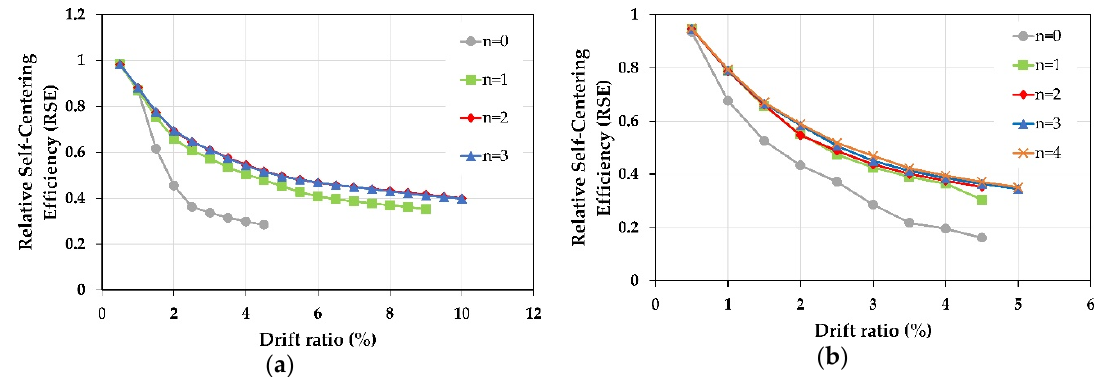
Figure 20. Effect of number of FRP layers: ( a ) The column C-C-SMA2; ( b ) the column R-B-SMA2.